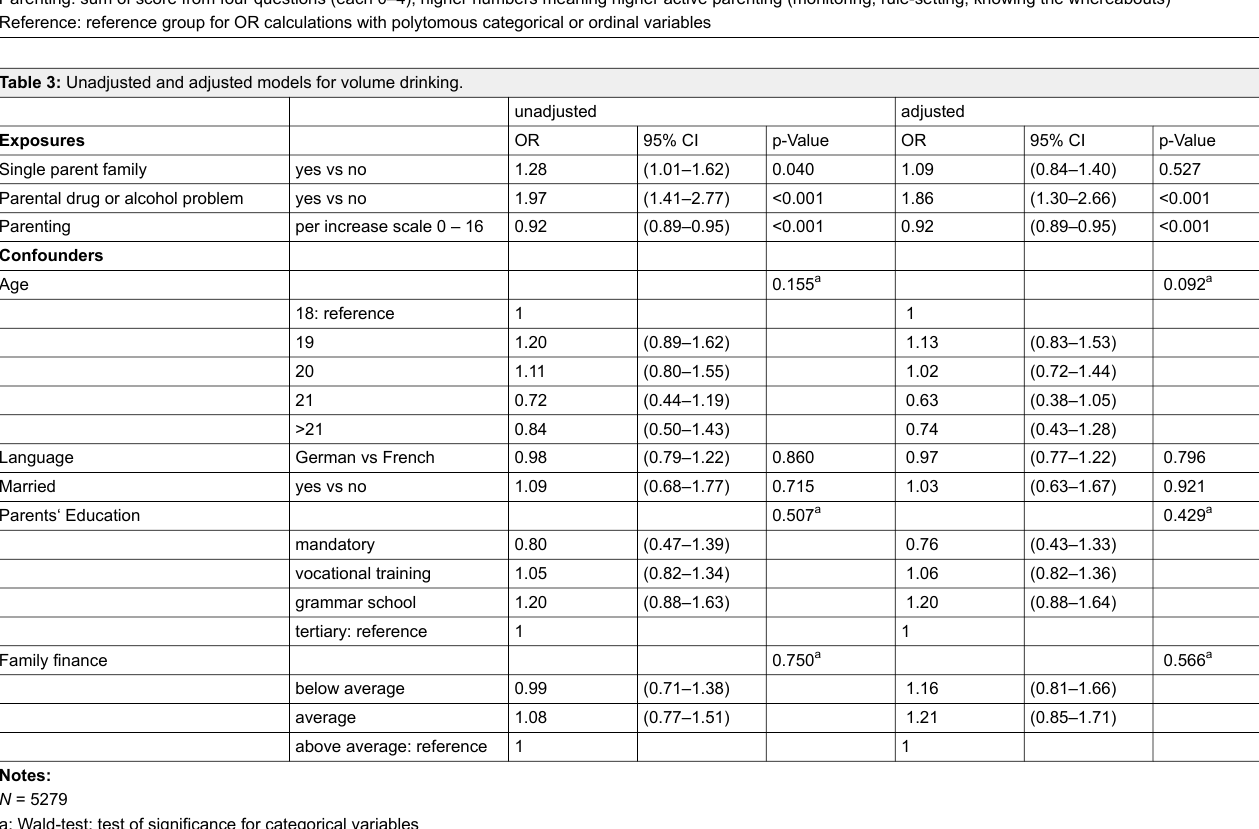
Table 3: Unadjusted and adjusted models for volume